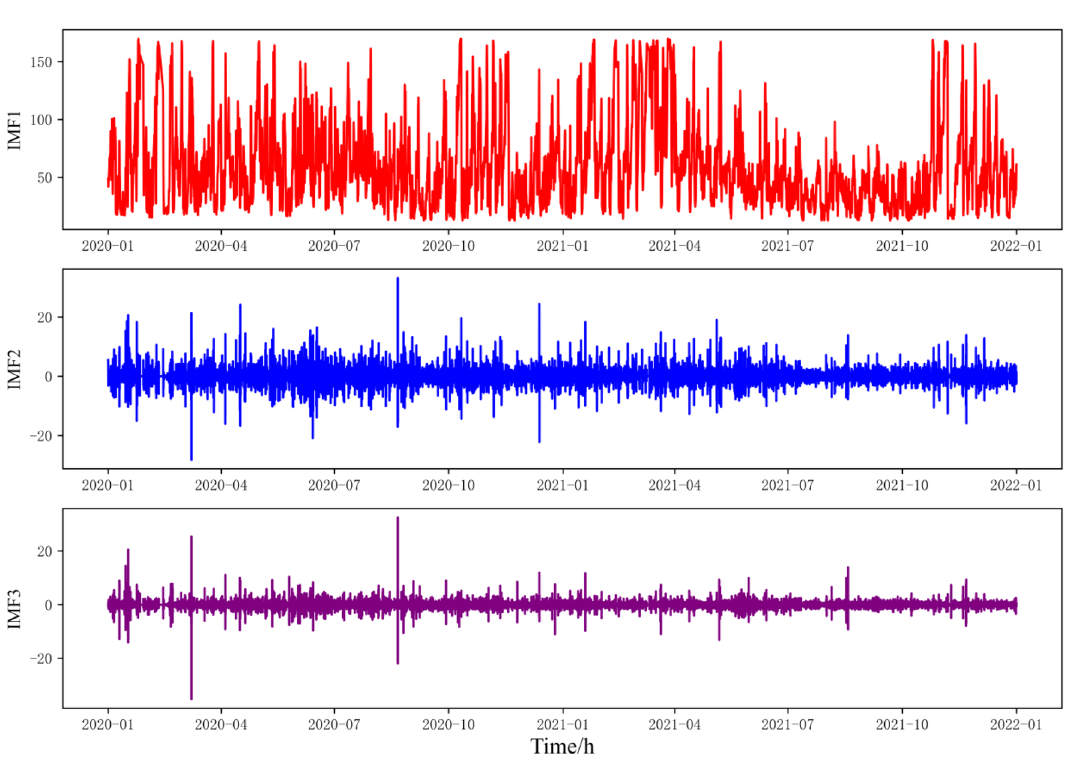
Figure 8. SSA decomposition